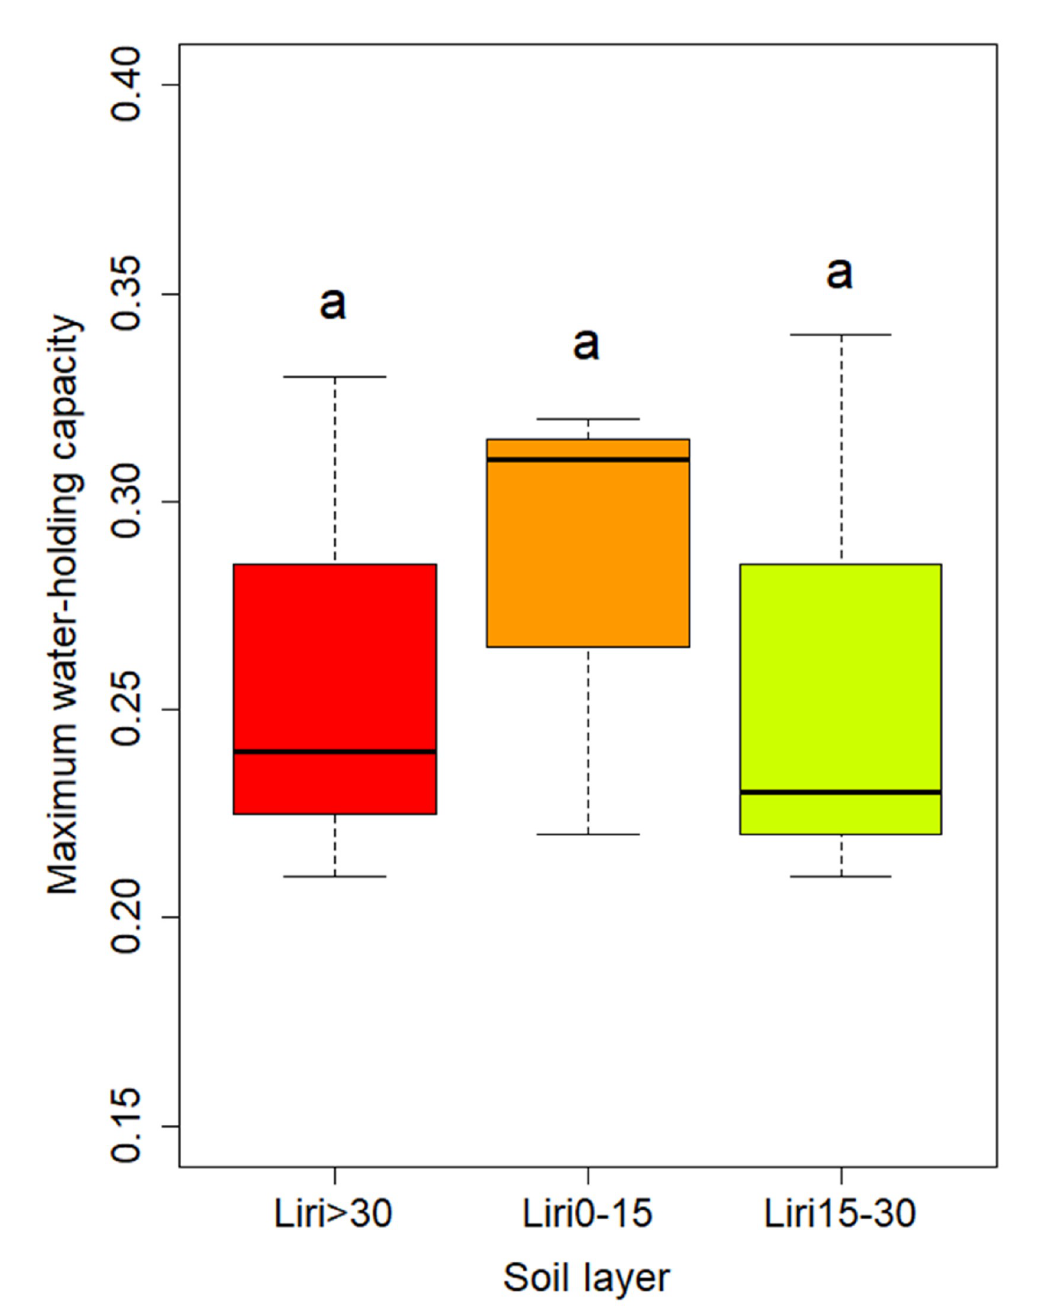
Fig 4. Liriodendron chinensis maximum water-holding capacity in different soil